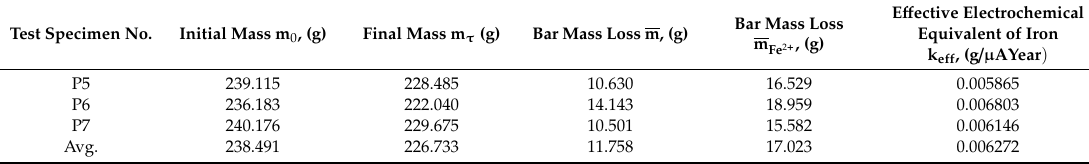
Table 3. Comparison of the results of the gravimetric analysis and the calculations of the bar mass loss with the use of Faraday’s law for the samples complementing the first series of tests. Test Specimen No.